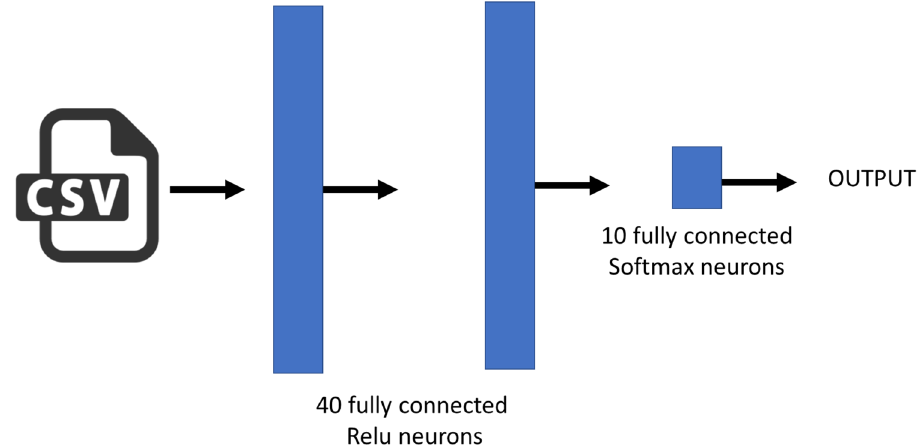
Figure 7. ANN architectures implemented for classification based on the extracted